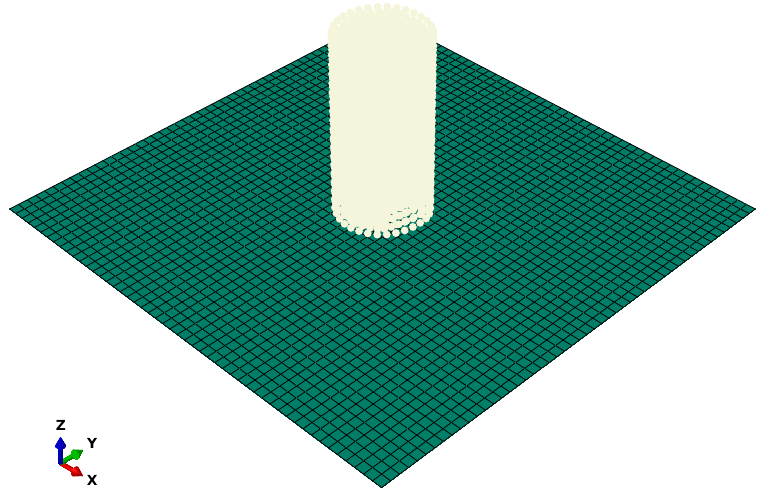
Figure 1. Numerical model of the bird projectile and the square laminate. Finite element method (FEM) meshes are indicated by the dark cyan, smoothed particle hydrodynamics (SPH) particles are indicated by the greyish white.